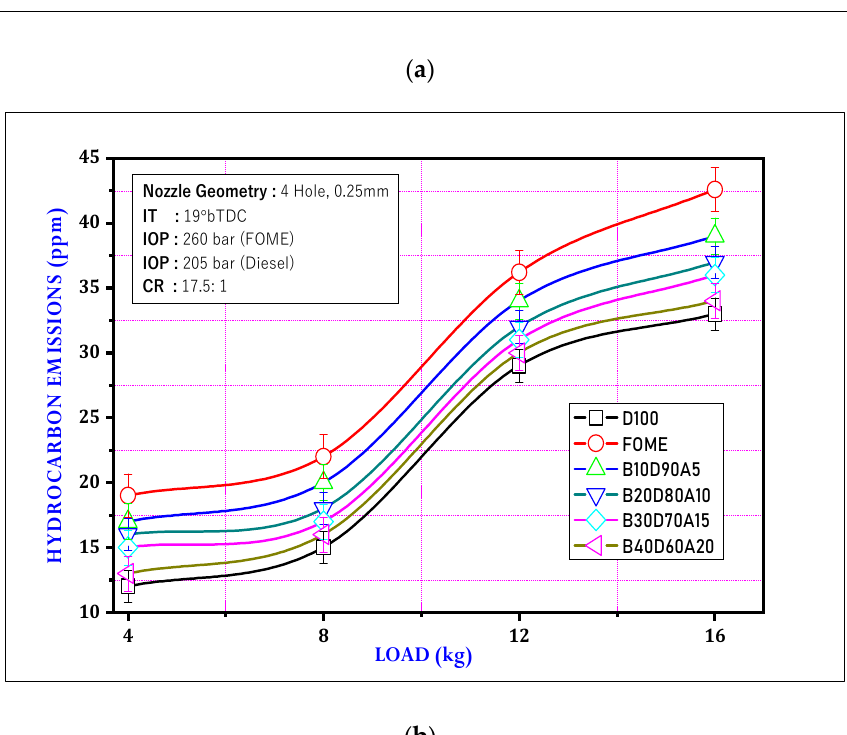
Figure 11a,b illustrate the variations in NO X emissions with load for the blends of diesel, FOME, and Al 2 O 3 nanoparticles at three-hole- and four-hole nozzle geometries, re- spectively.